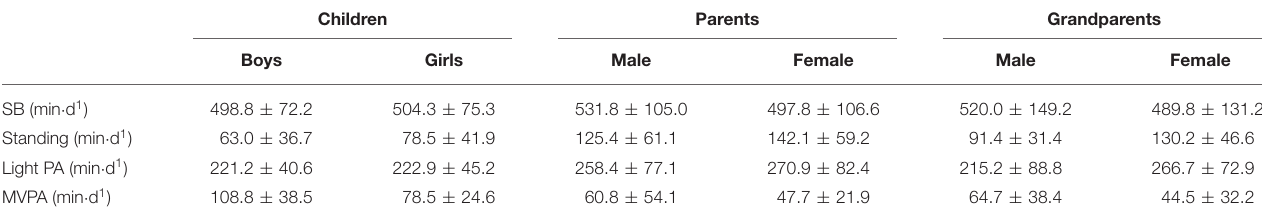
TABLE 2 | Means and standard deviations for minutes per day of PA and SB.